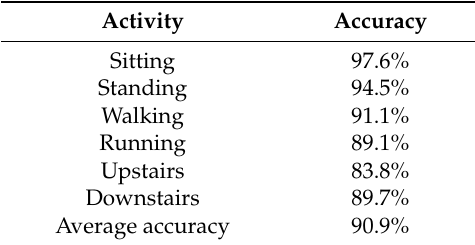
Table 3. The performance of the H-SVM classification.